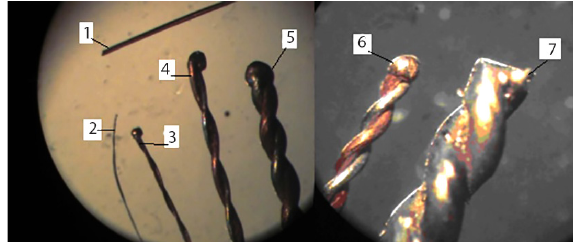
Figure 2. Individually manufactured temperature measuring sensors of various thicknesses: 1 – human hair 0.04 mm; 2 – temperature sensor 0.005 mm; 3 – sensor 0.03 mm; 4 – sensor 0.07 mm; 5 – sensor 0.18 mm; 6 – sensor 0.3 mm;